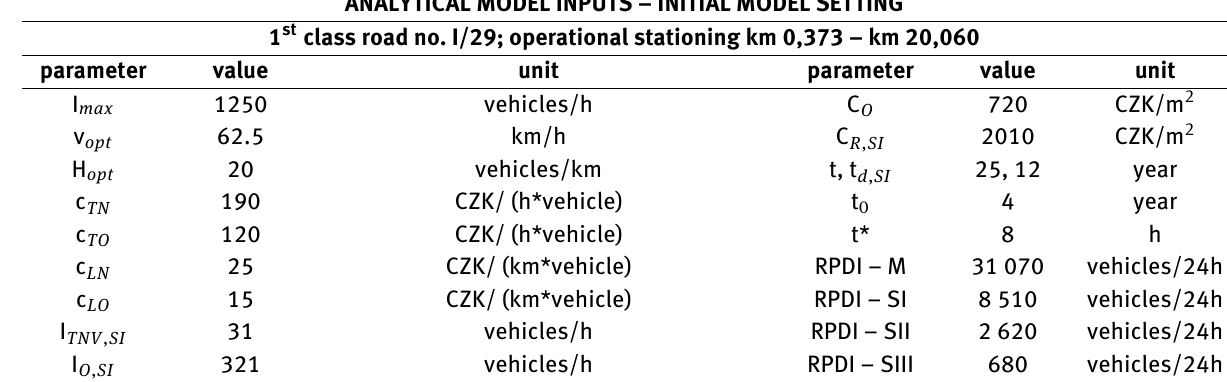
Table 4: Inputs to the application based on the analytical model for the 1 st class road no. I/29 [1] ANALYTICAL MODEL INPUTS – INITIAL MODEL